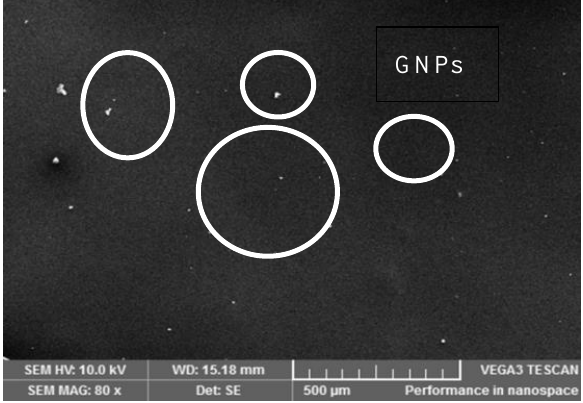
Figure 5. A Scanning Electron Microscope (SEM) image of the Graphene Nano-Platelets (GNPs) in the asphalt binder (500 µ m).